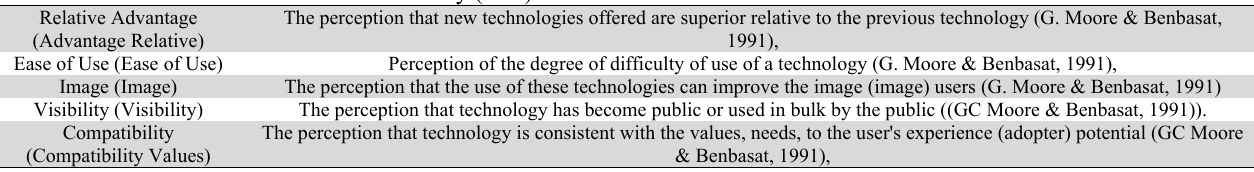
Constructs Innovation Model Diffusion Theory